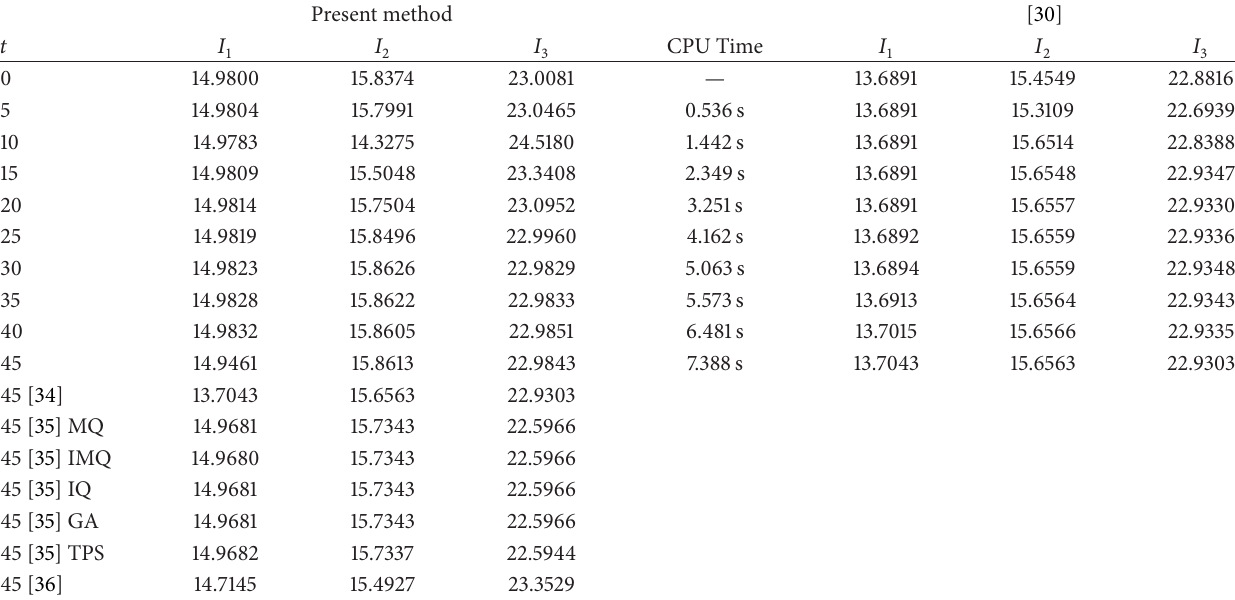
Table 7: Comparison of invariants for the interaction of three solitary waves with results from [30] with ℎ = 0.2 , 𝑘 = 0.025 in the region 0 ≤ 𝑥 ≤ 250 . Present method